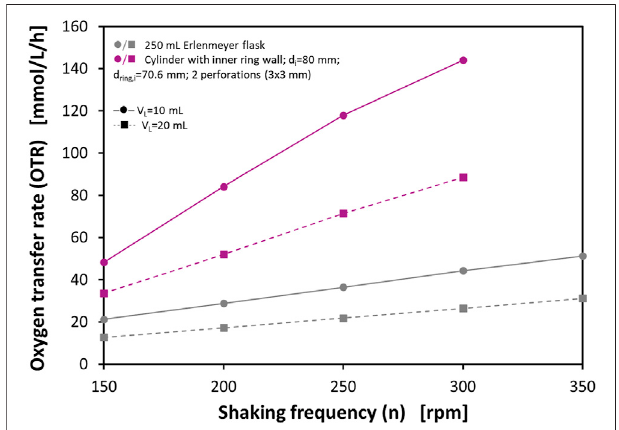
FIGURE 4 | Maximum oxygen transfer capacities (OTR max ) of a perforatedring fl askwithinnervesseldiameterd i =80 mm,innerringdiameter d ring,i = 70.6 mm, wall thickness d wall = 2.2 mm, and 2 perforations of 3 mm × 3 mm size in 0.5 M sul fi te system. The data show both measured OTR max with RAMOS of cylindrical vessels and perforated ring fl asks and calculated OTR max levels for a 250 ml shake fl ask according to Meier et al. (2016). Experimental conditions: 0.5 M Na 2 SO 3 , 0.012 M phosphate